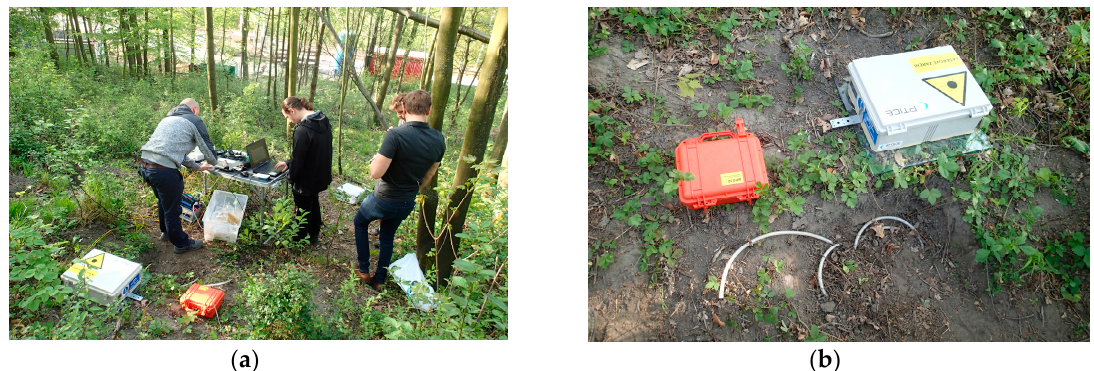
Figure 10. ( a ) The in-situ laboratory on April 26, 2019; ( b ) measuring instrumentation arrangement—the buried acoustic sensor in the foreground, the interferometric sensor on the right, the BRS32 apparatus on the left.